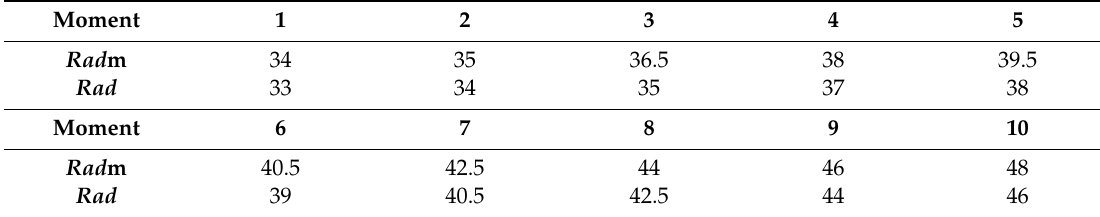
Table 3. The danger sector after changing Ship 1’s manoeuvrability in a head-on scenario.